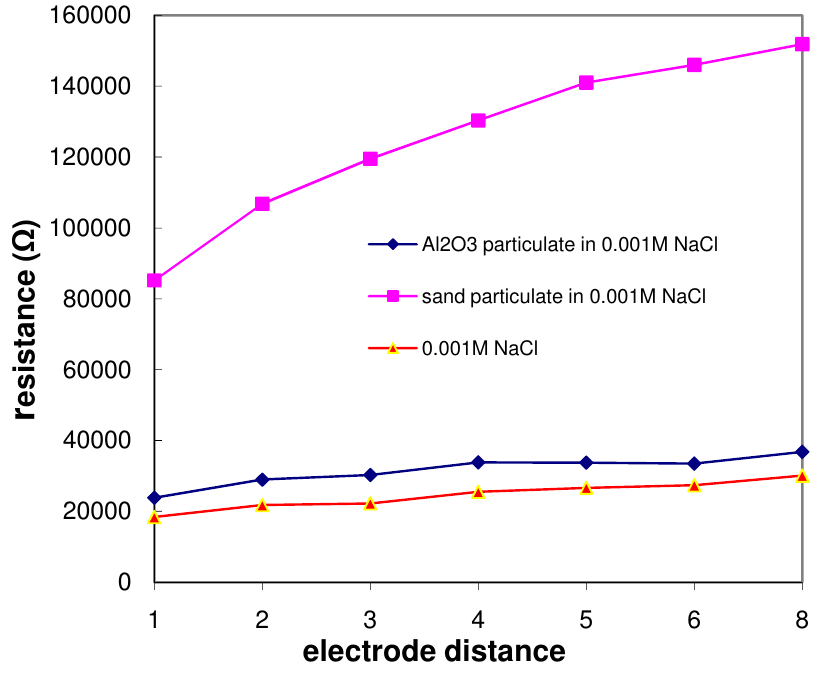
Figure 6. Particulate size effect on layer resistance (layer thickness: 8 mm): sand particulates with largest size introduces dramatic increase in layer resistance,